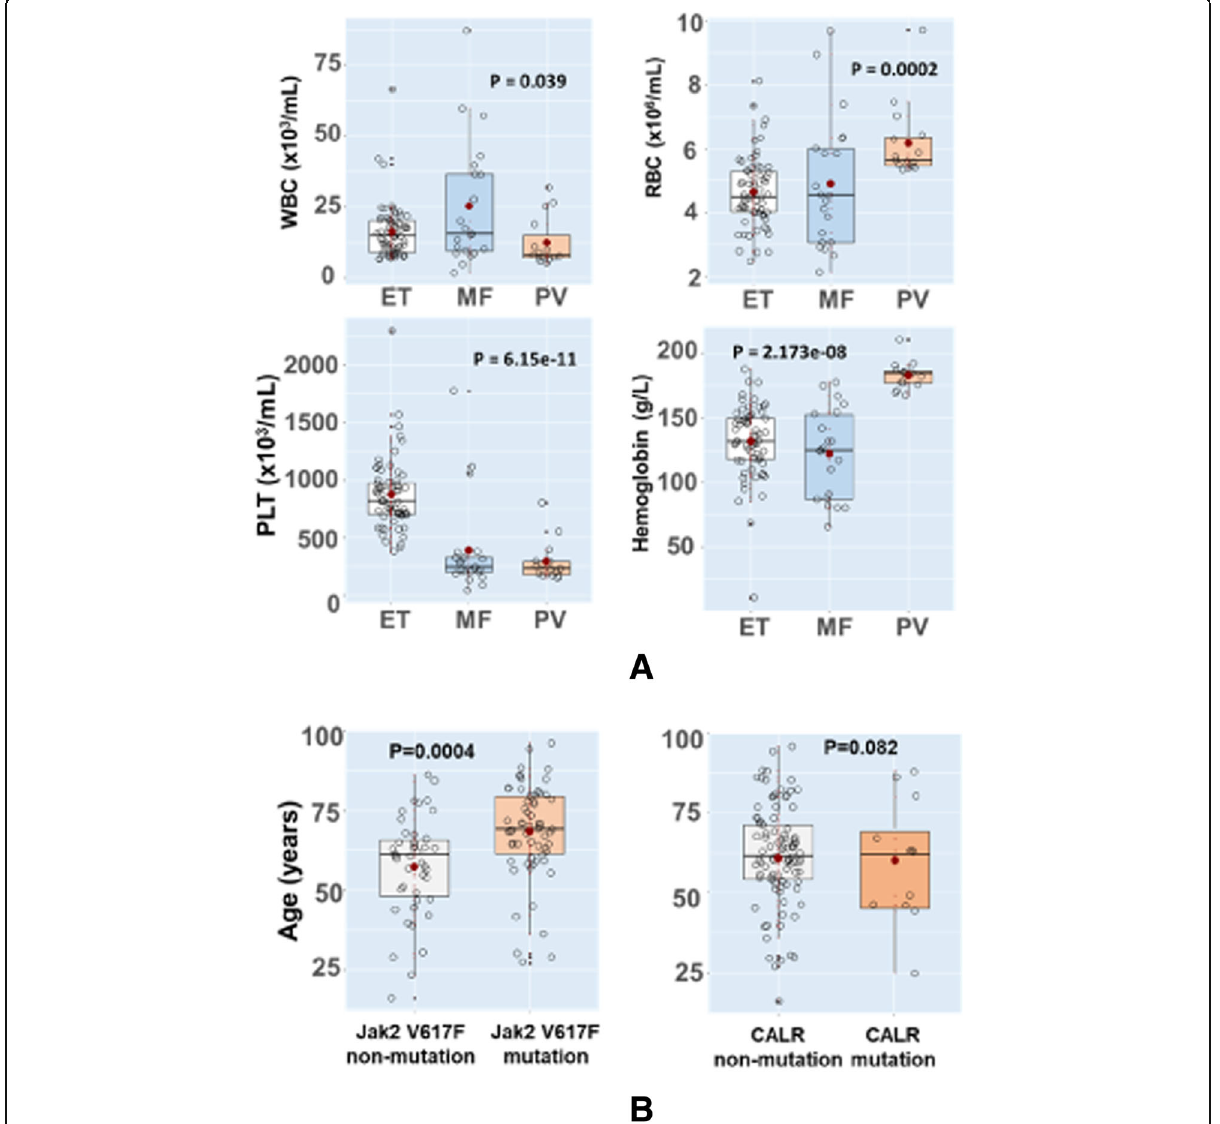
Fig. 2 Distribution of haematological values and Jak2 V617F, CALR mutant alleles in different study population. Panel a : Haematological parameters in: ET, PMF and PV subgroups. Panel b : Age distribution and Jak2 V617F and CALR mutations; PLT: platelets; WBC: white blood cell; RBC: red blood cell; PLT: platelet; Hb: